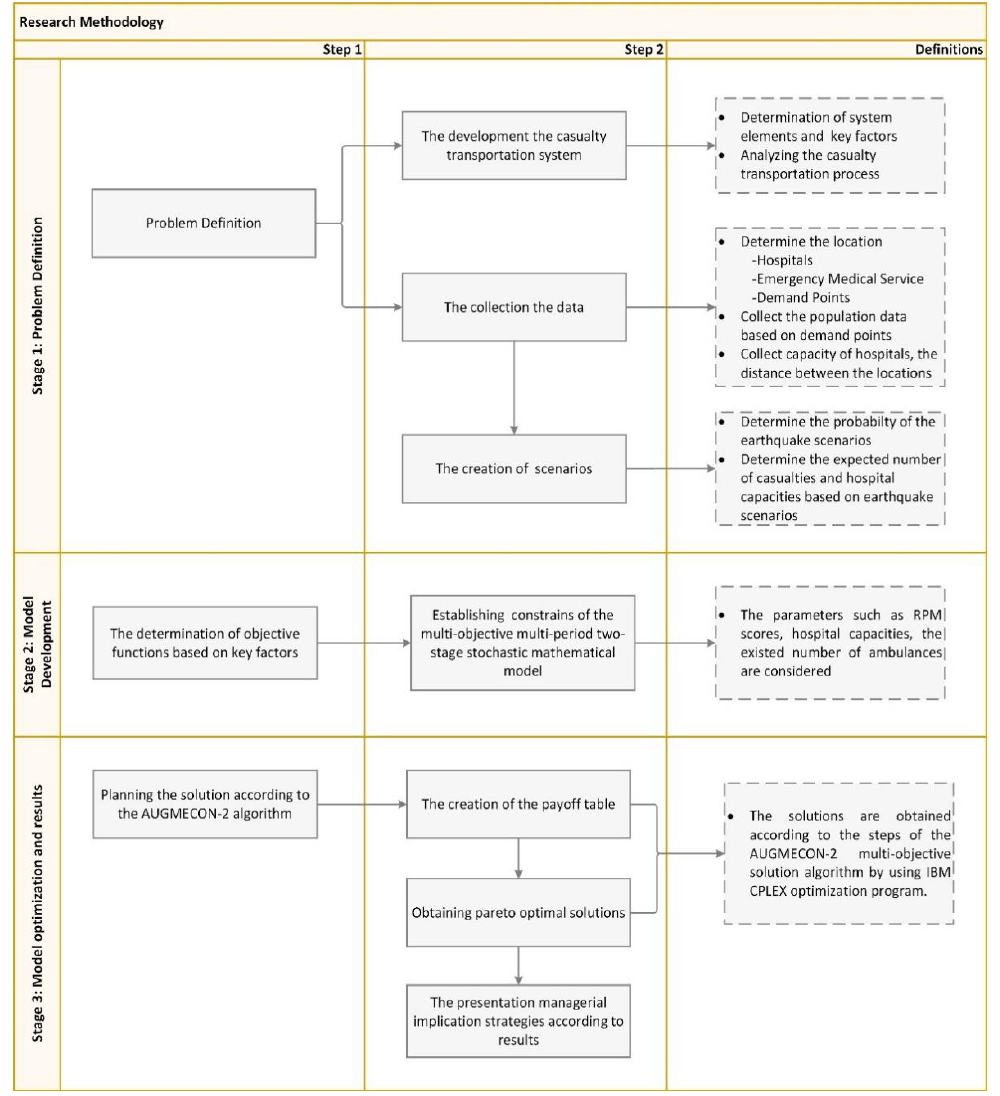
Figure 1. Research methodology flow diagram.